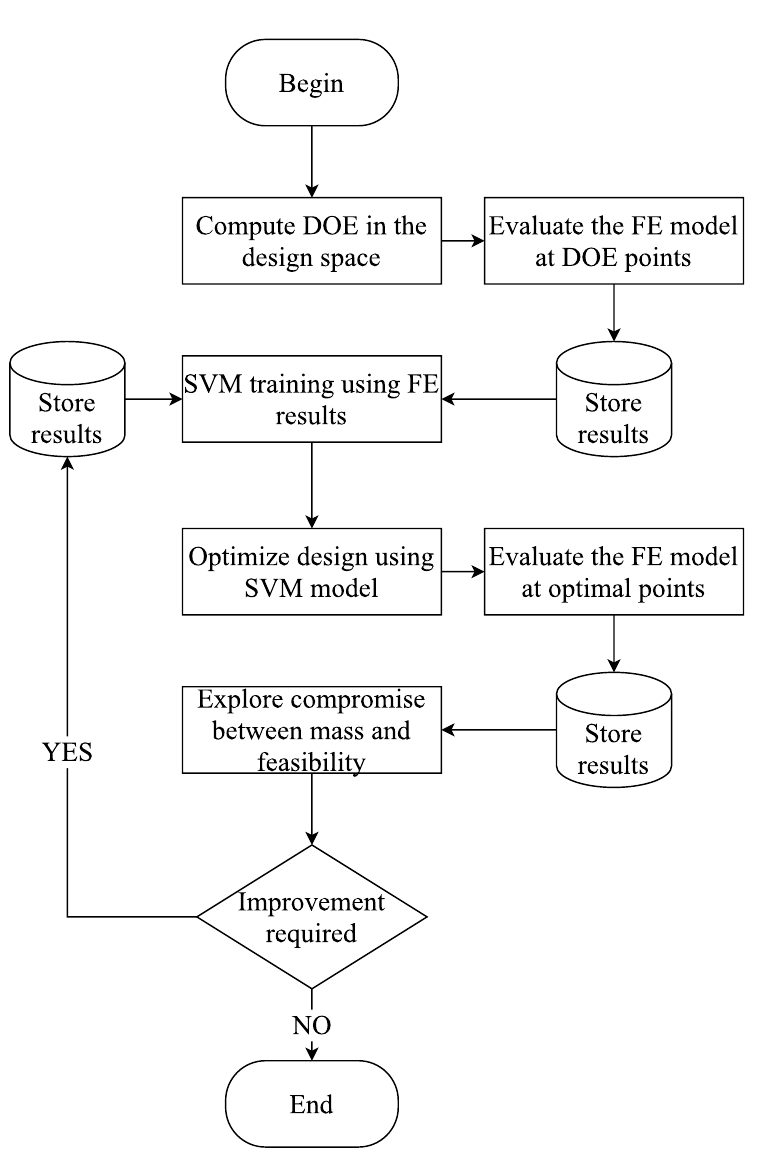
Figure 8. Optimization